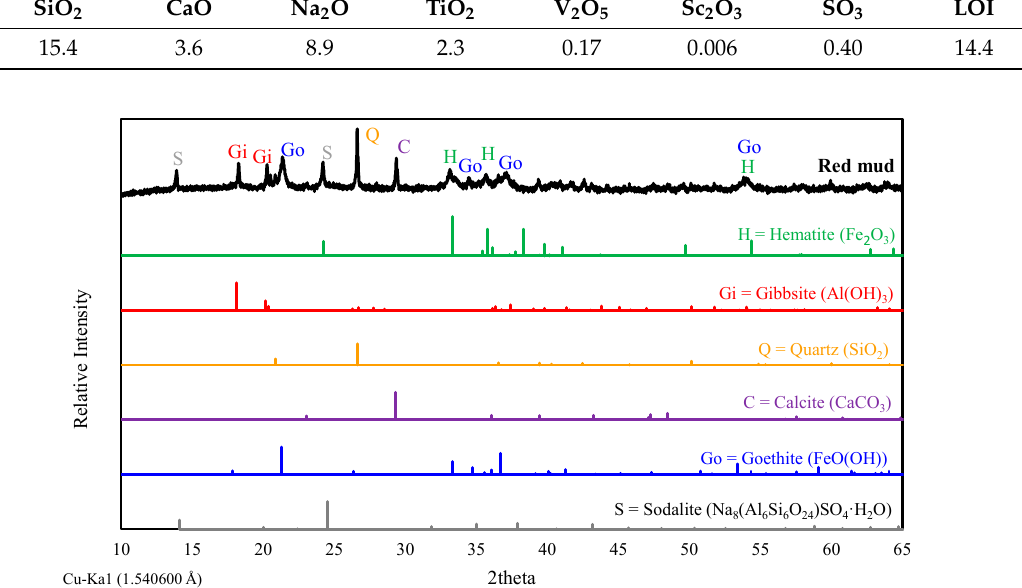
Figure 1. X-ray diffraction pattern of red mud.